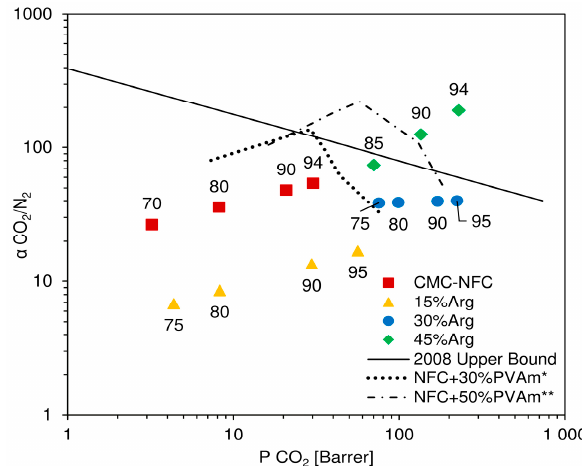
Figure 10. Ideal selectivity of NFC with various contents of L -arginine compared to Robeson’s upper bound and NFC/Polyvinylamine blends from previous works [50,51].